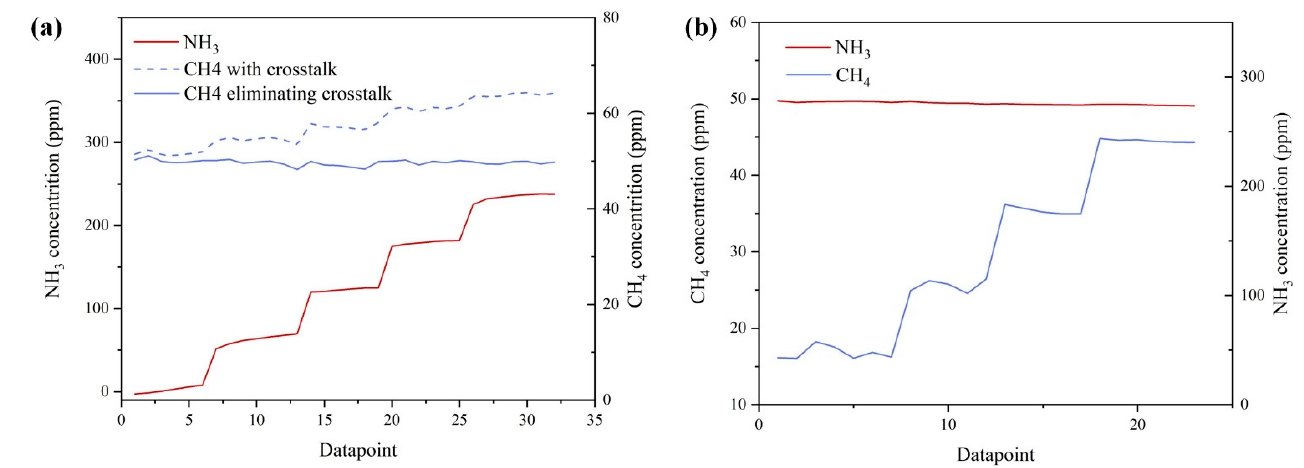
Figure 8. Simultaneous measurement: ( a ) Plot of fluctuating concentration of NH 3 while CH 4 remains constant. The dashed blue line is obtained without eliminating the crosstalk of NH 3 . The blue line is obtained after elimination. ( b ) Plot of fluctuating concentration of CH 4 while NH 3 stays constant.